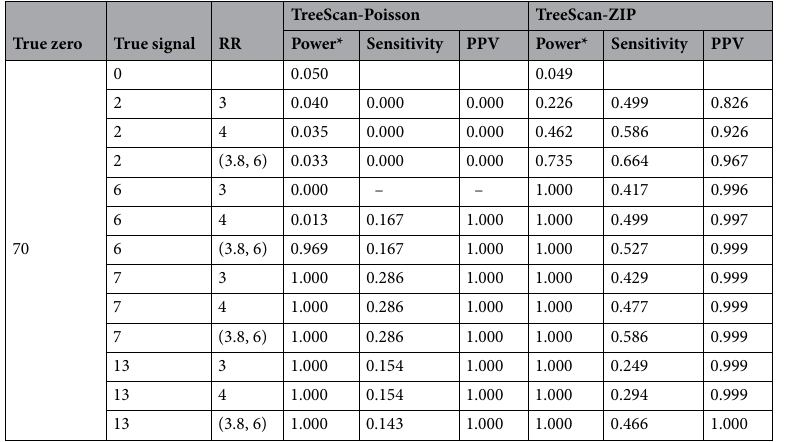
Table 2. Type I error, power, sensitivity and positive predictive value obtained by the two methods according to the number of true signals and relative risk. * Type I error when the number of true signals is